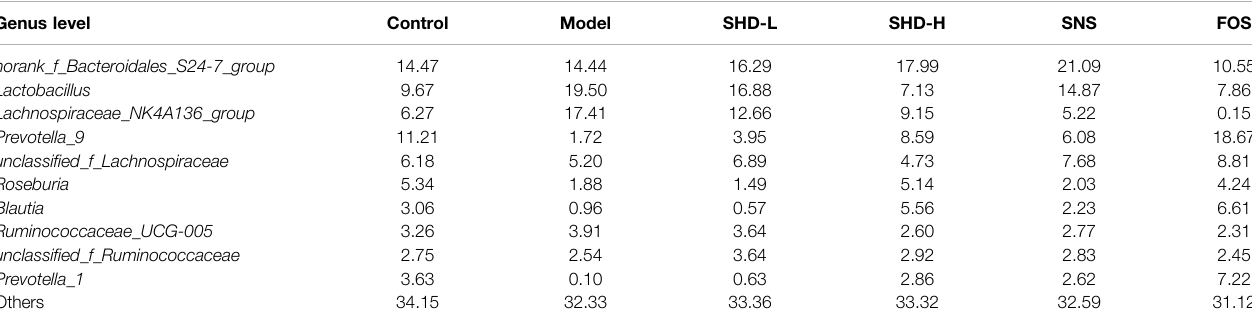
TABLE 3 | Effect of SHD on bacterial abundance (by genus) in each group of rats (%, n (cid:2) 7 – 8) Genus level Control